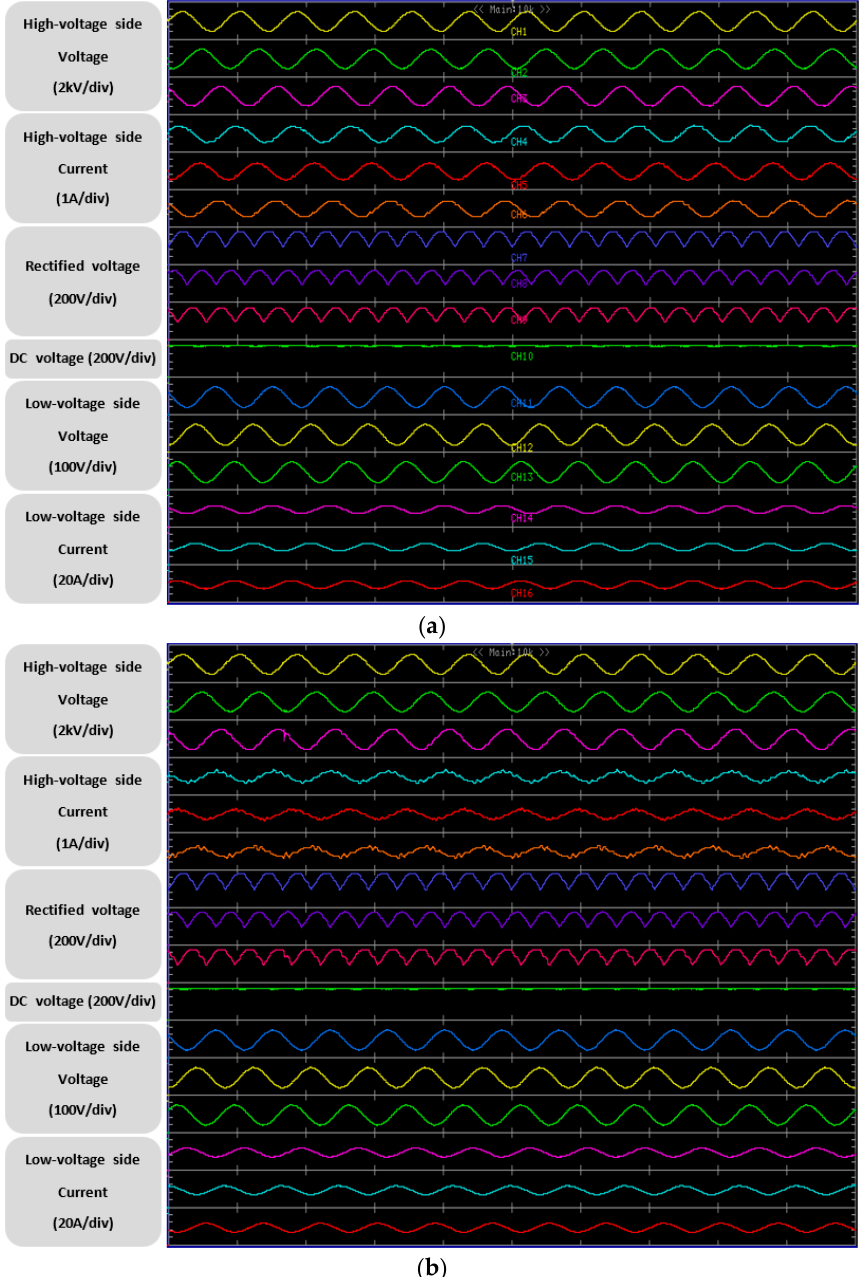
Figure 12. Experimental results in normal operation: ( a ) forward power flow; ( b ) reverse power flow.